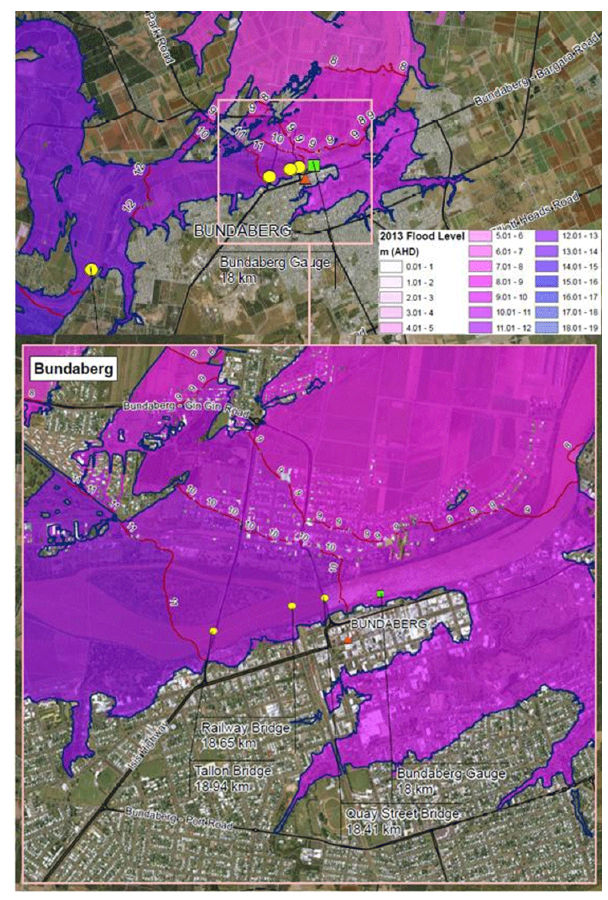
Figure 4. Inundation map of 2013 flood (Bundaberg Regional Council,